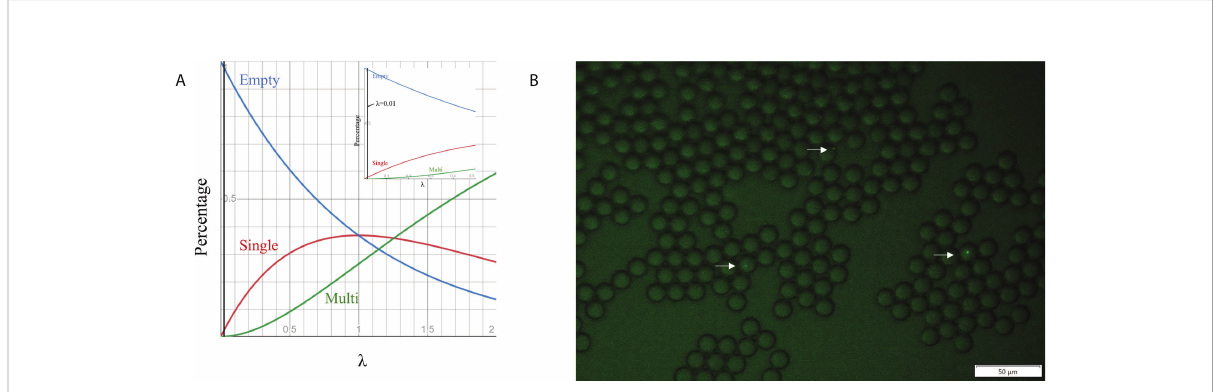
FIGURE 3 Cell encapsulation in droplets. (A) Relationship between the percentage of droplets containing different cell numbers and l , which is the average number of cells per droplet volume. (B) Fluorescence images of droplet occupancy at 7×10 6 cell numbers per ml (the most frequently used cell loading